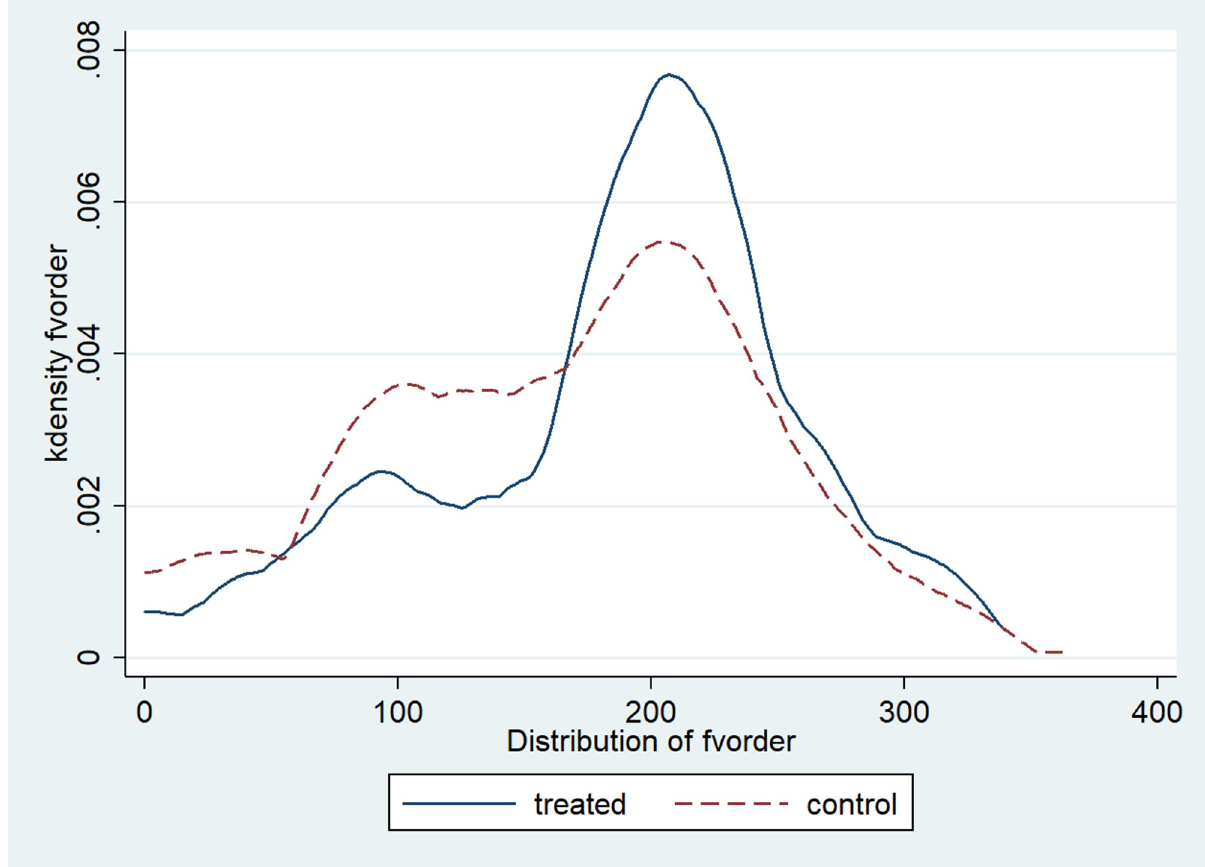
Fig 1. Distribution of fruits and vegetables